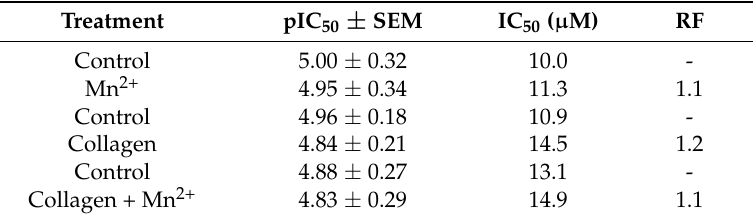
Table 1. Cisplatin IC 50 on MV3 cell line.